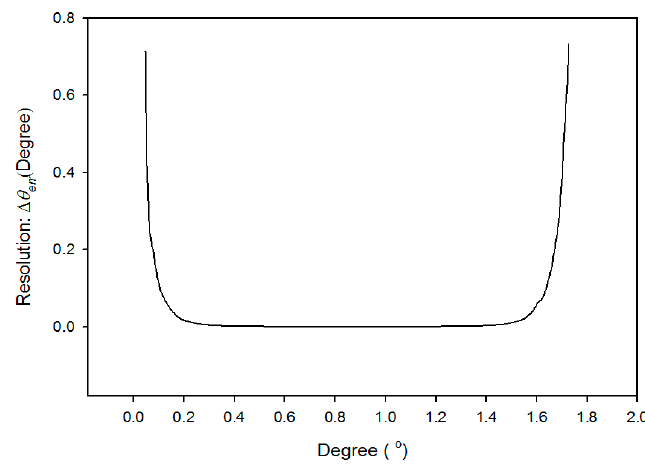
Figure 10. The resolution of experimental architecture ( σ is 0.976).